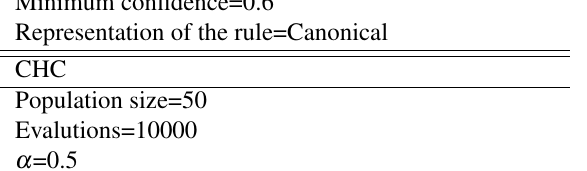
Table 2. Parameters of the algorithms employed NMEEF-SD Population size=50 Evaluations=10000 Crossover probability=0.60 Mutation probability=0.1 Re-initialisation based on coverage (50% of biased) Minimum confidence=0.6 Representation of the rule=Canonical CHC Population size=50 Evalutions=10000 α